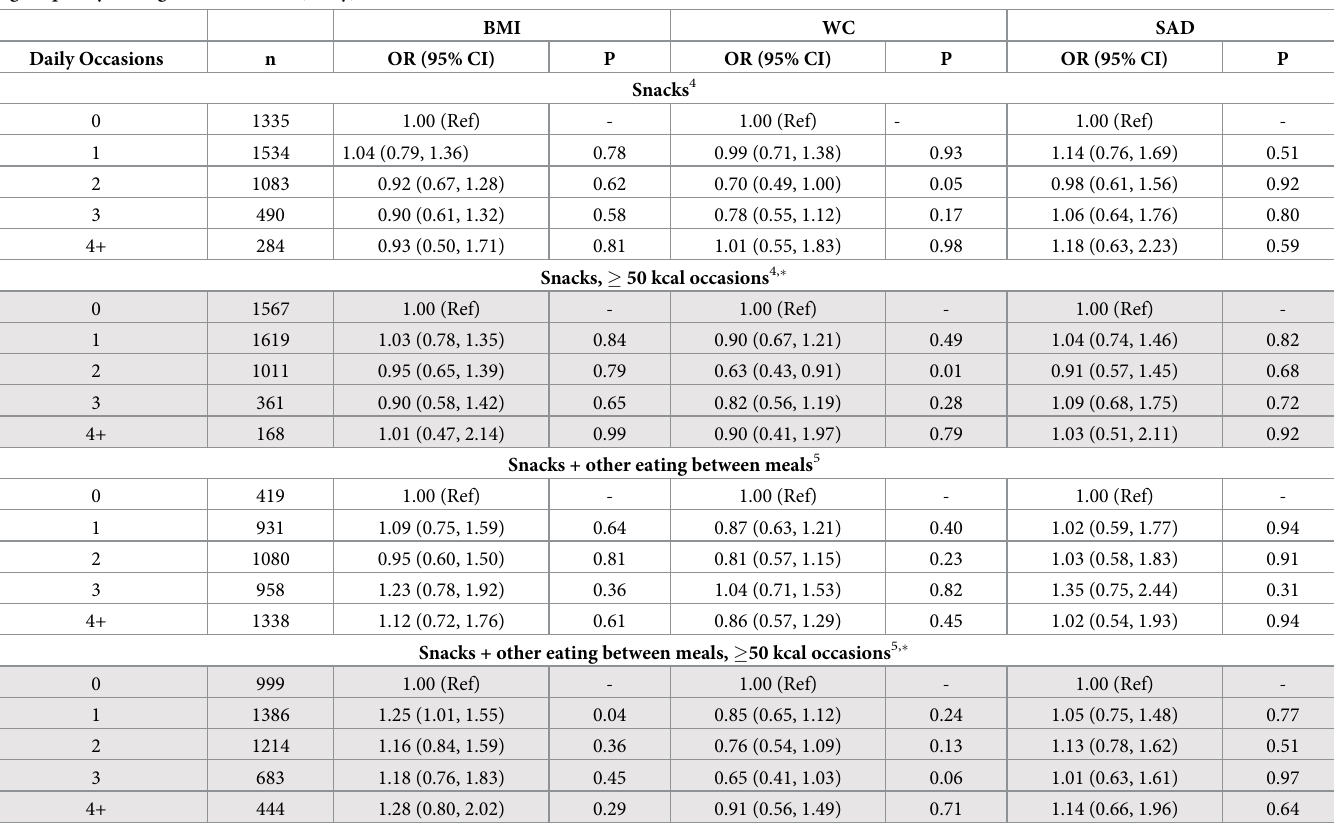
Table 4. Odds ratio of overweight or obesity (BMI � 25 kg/m 2 ), Waist Circumference (WC) > 102cm, and Sagittal Abdominal Diameter (SAD) > 25cm with snack- ing frequency among U.S. adult men ( � 20y), NHANES 2013–2016 1-3